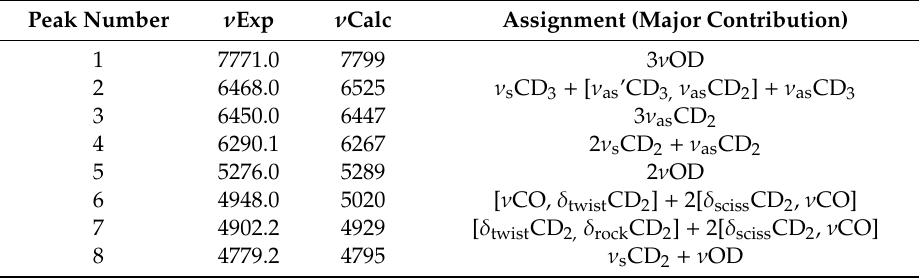
Band assignments in NIR spectra of CD 3 CD 2 OD based on GVPT2 // B2PLYP-GD3BJ / def2-TZVP // CPCM calculations. Band numbering corresponds to that presented in Figure